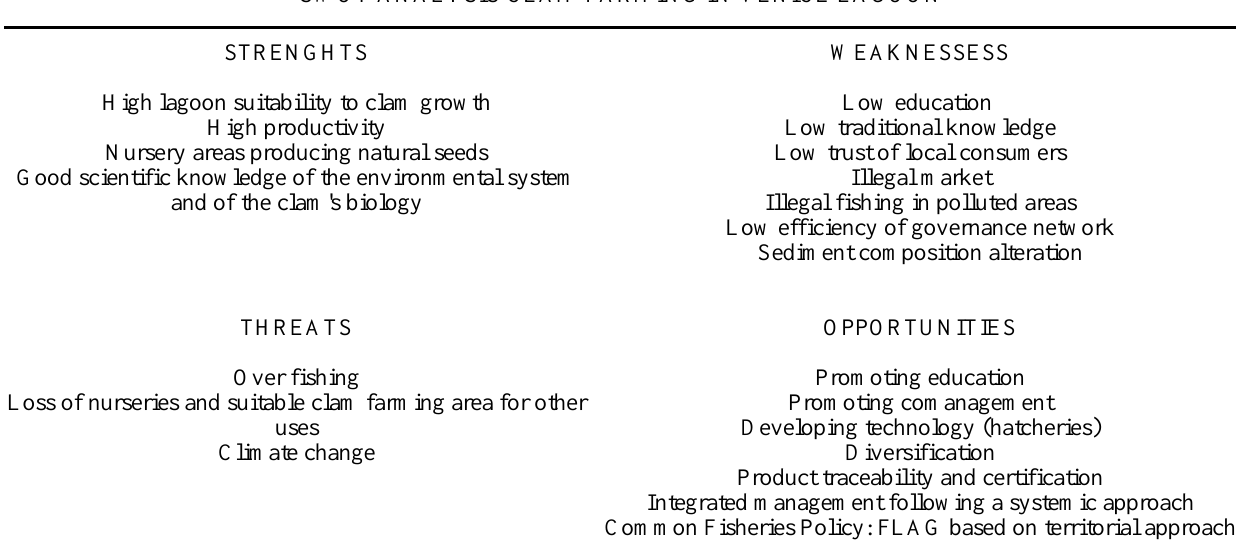
Table 2. Strengths, weaknesses, opportunities, and threats (SWOT) analysis of clam farming in the Venice Lagoon. Adapted from Torricelli et al.